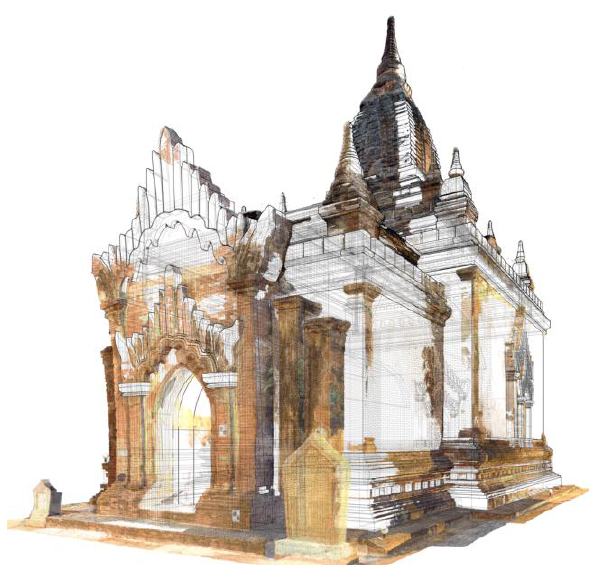
Figure 1: Building information model of Loka Hteik Pan temple, Bagan, Myanmar